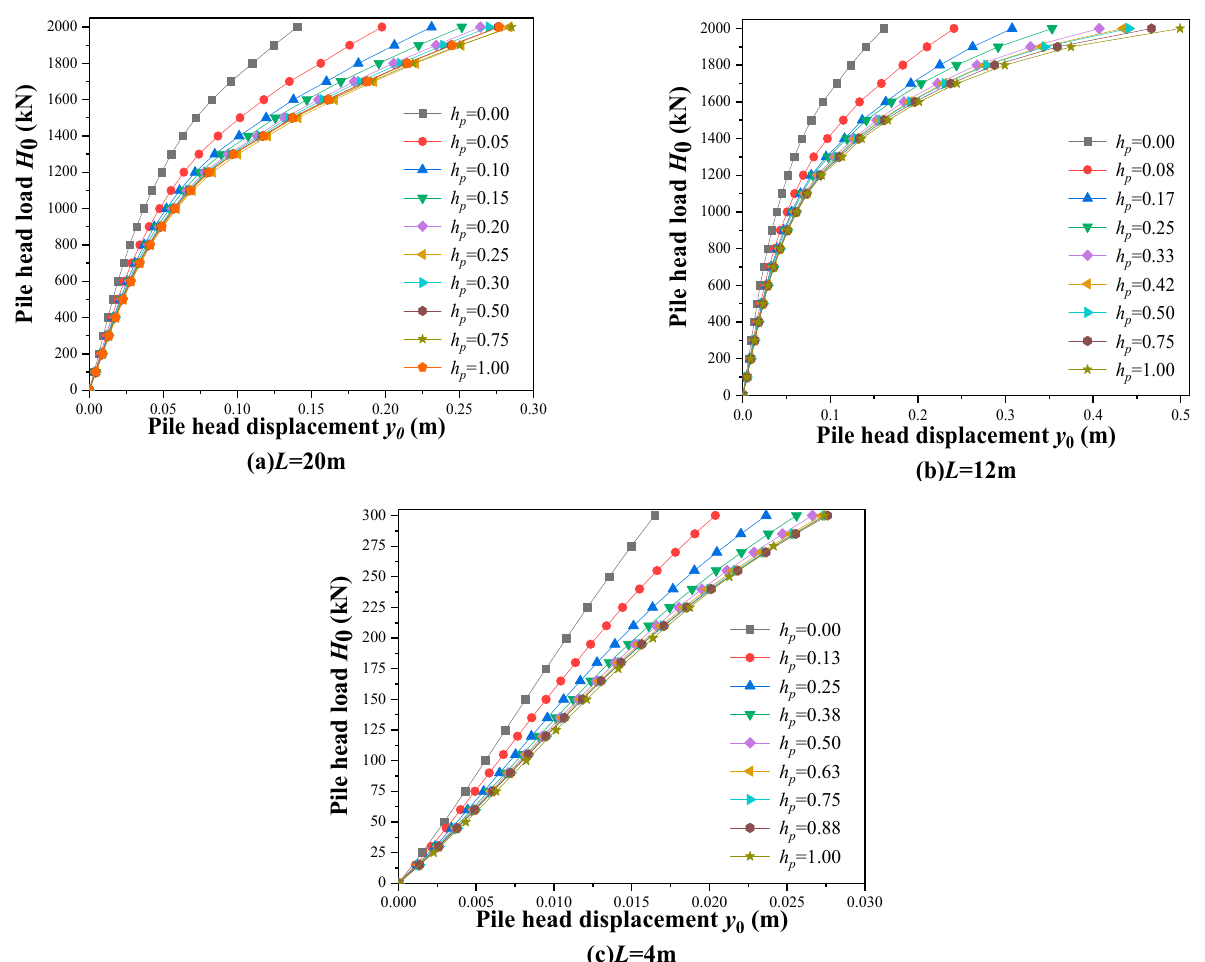
wedge failure body, as shown in Figure 10, where 𝜙 is the angle between the sliding sur- face and the vertical plane. Under undrained conditions, the angle ( 𝜙 ) is suggested to be Figure 9. Effect of the dimensionless slope height ( ℎ (cid:2926) ) on pile-head displacement for slope angle Figure 9. Effect of the dimensionless slope height ( h p ) on pile-head displacement for slope angle 45° by Reese et al. [41]. 𝜃 = 45° . Piles of ( a ) 20 m, ( b ) 12 m, and ( c ) 4 m lengths. θ = 45 ◦ . Piles of ( a ) 20 m, ( b ) 12 m, and ( c ) 4 m lengths. The phenomenon can be explained by a wedge failure theory first proposed by Reese and Welch and Reese et al. [40,41]. The wedge failure model considers that the soil–pile response relates to the lowest value of two possible failure mechanisms: a wedge failure mechanism at shallow depths and a flow failure around the pile at greater depths. More- over, the passive wedge develops along the depth as the load increases to form a larger